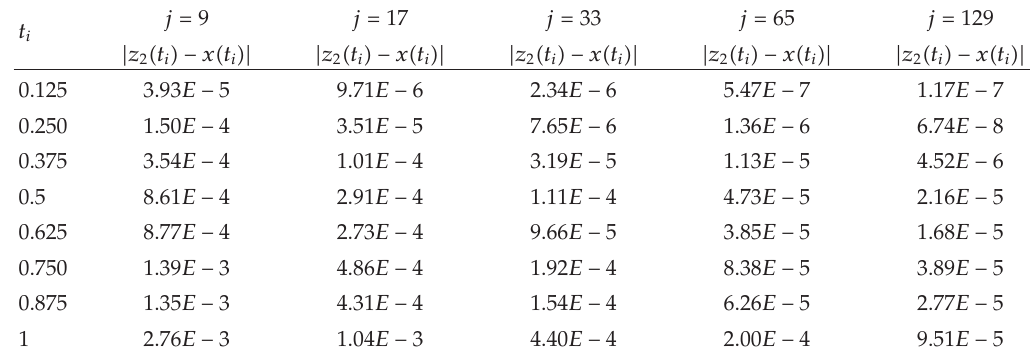
Table 1: Absolute errors for Example 4.1.